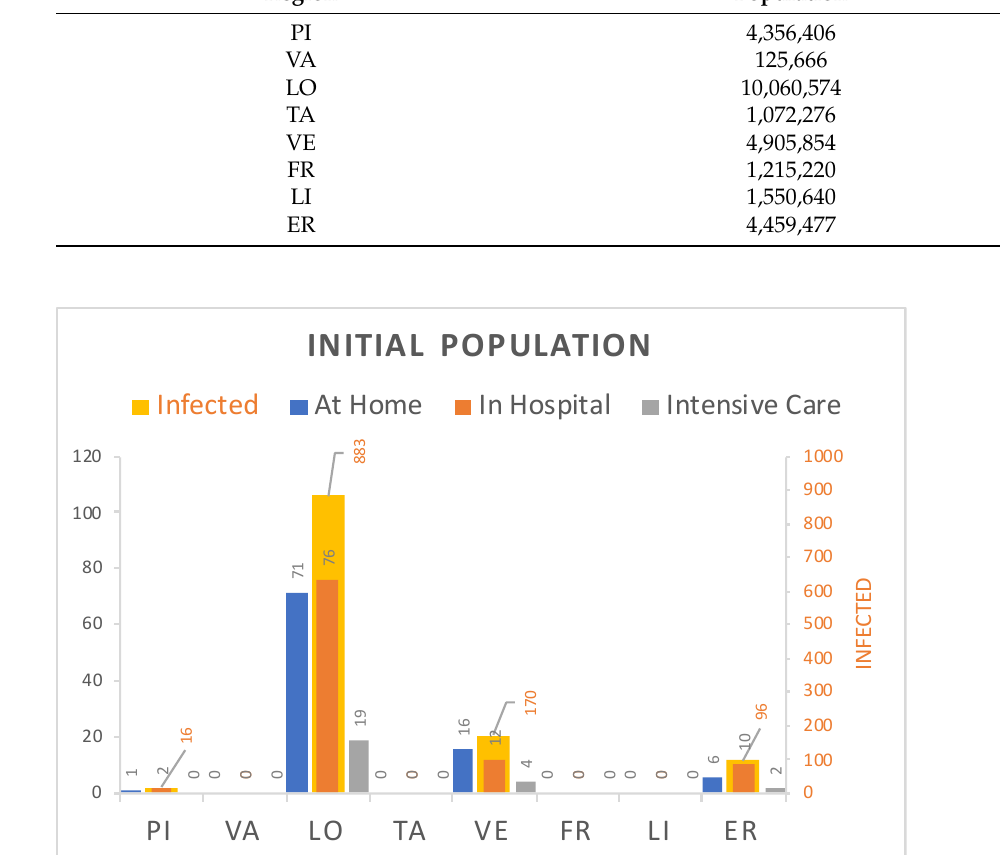
Figure 2. Initial agent